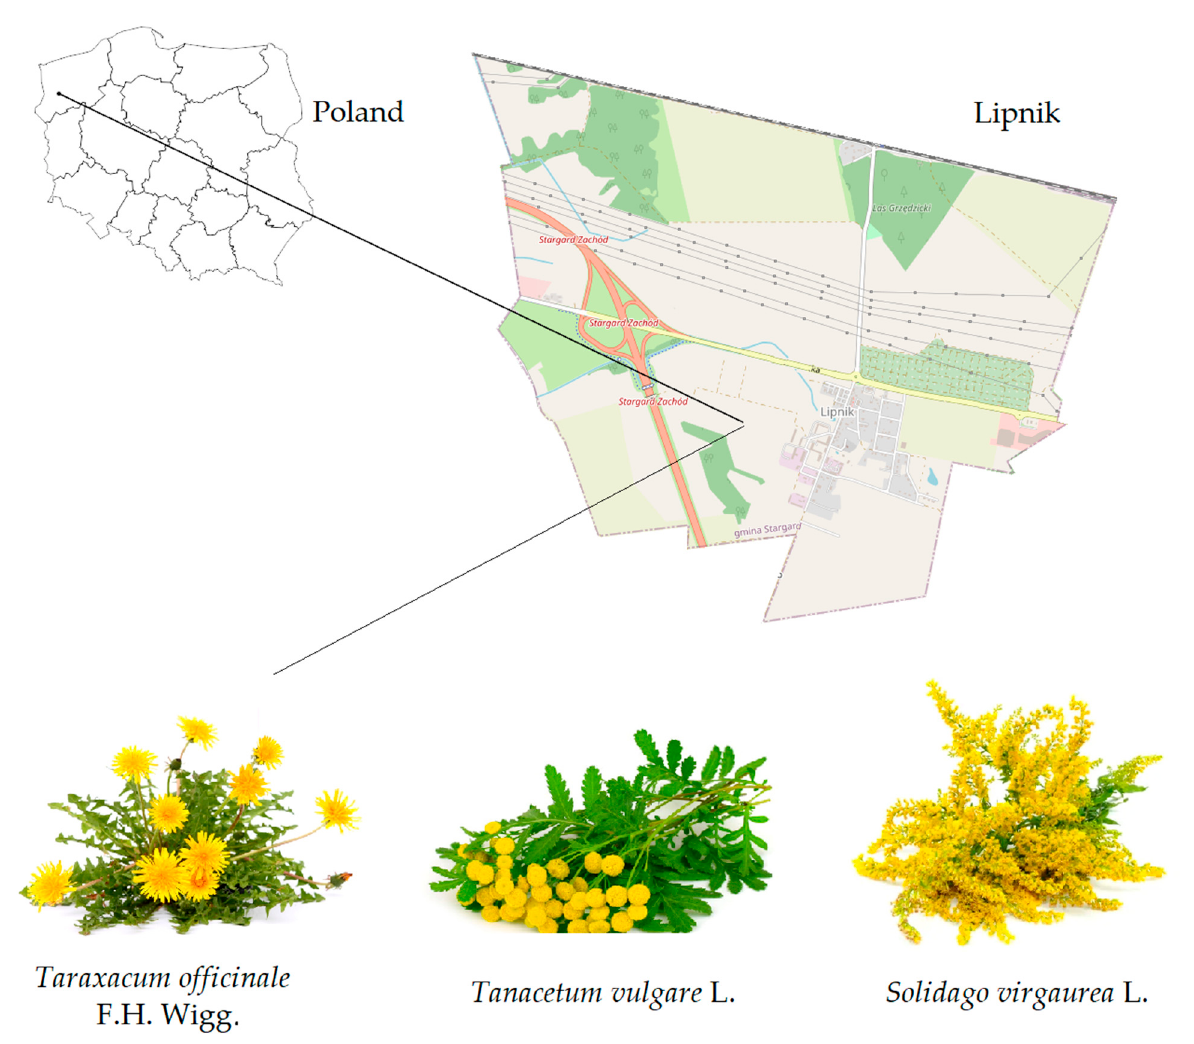
Figure 1. The map of the collection region.